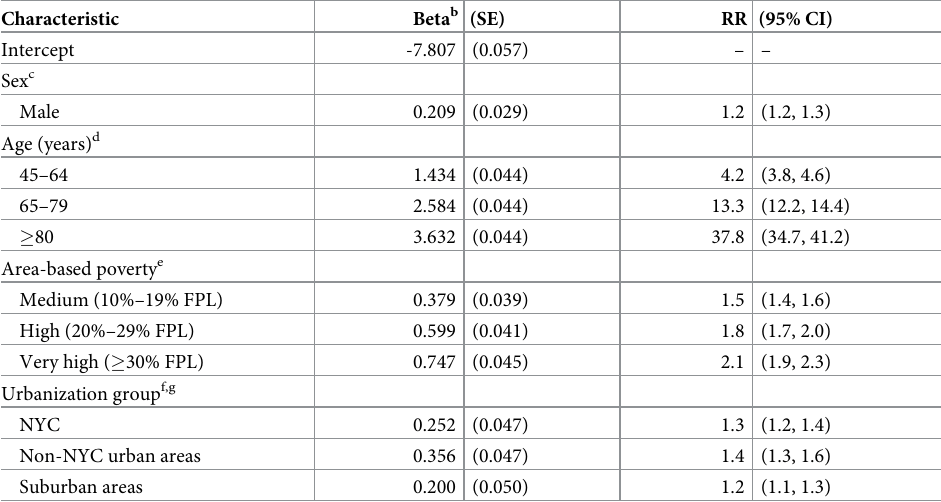
Table 3. Multivariable negative binomial regression estimating community-setting pneumonia-associated hospi- talization rate ratios—New York State, 2010–2014 a .